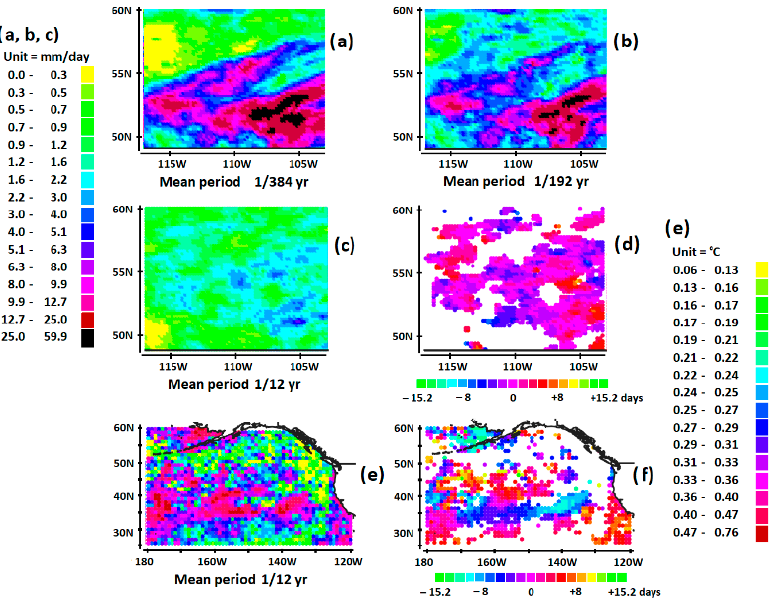
Figure 7. Extreme rainfall in Alberta. The amplitude ( a – c ) and the phase ( d ) of the precipitation depth, and the amplitude ( e ) and the phase ( f ) of the SST anomalies. Time lags in ( d , f ) are expressed in relation to 6 June 2005. The time reference is the rainfall depth at 50 ◦ N, 114 ◦ W. Co-Evolution of SST and Rainfall Anomalies in Characteristic Period Ranges From Figure 7c,d, clustering of rainfall anomalies occurs in the two branches, where the 1/12 harmonic of the precipitation is almost in phase with the ERE. The SST anomaly greater than 0.40 ◦ C, made up of two branches, develops along the California Current, between latitudes 30 ◦ N and 40 ◦ N (Figure 7e,f). The two branches are strongly out of phase. The southernmost branch is almost 8 days ahead of the occurrence of the ERE. The northernmost branch, the only one supplying the extratropical cyclone, is a few days behind the occurrence of the ERE, which means that the ERE occurs a little before the anomaly reaches its